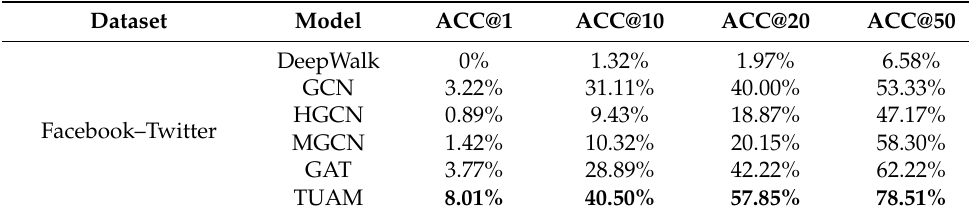
Table 3. The performance of different methods on ACC@K on the Facebook–Twitter dataset.